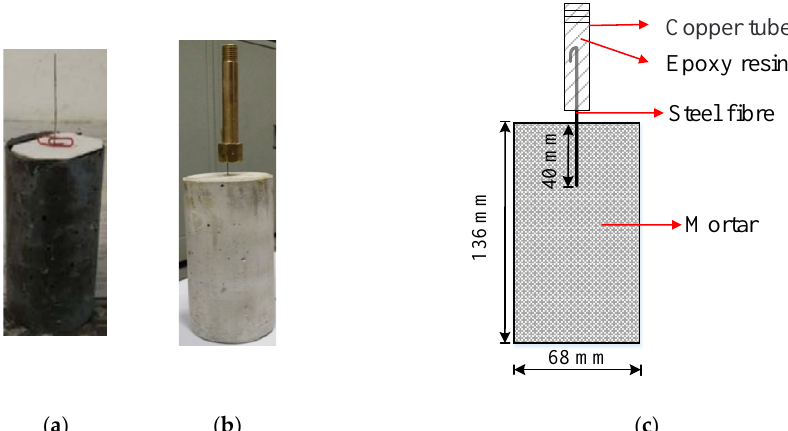
Figure 1. A specimen for the pullout test: ( a ) A specimen in mould; ( b ) A specimen demoulded; ( c ) The sketch.